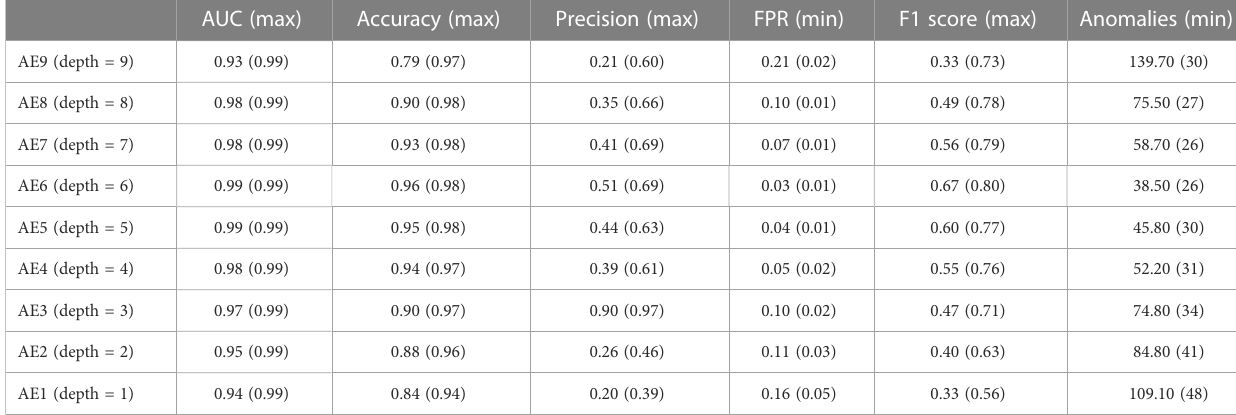
TABLE 2 Comparison of the autoencoder with different encoder layer